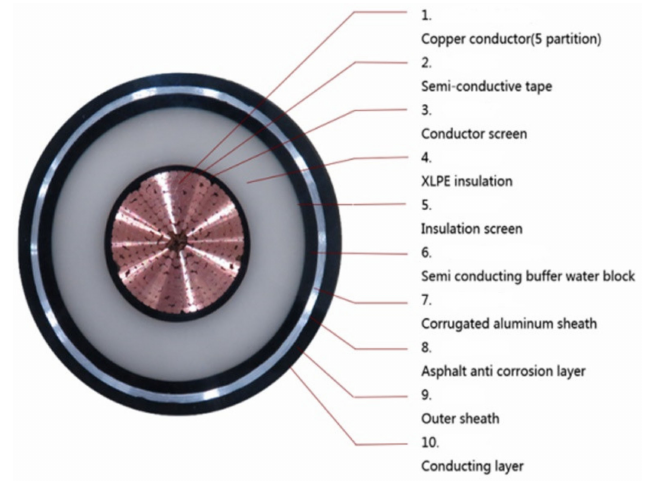
Figure 2. Cross-sectional model of high-voltage